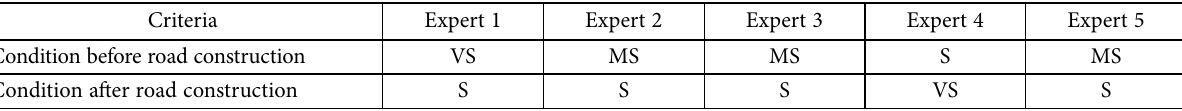
Figure 5. Membership scale for attribute ratings Table 4. Linguistic ratings of the criteria given by the experts